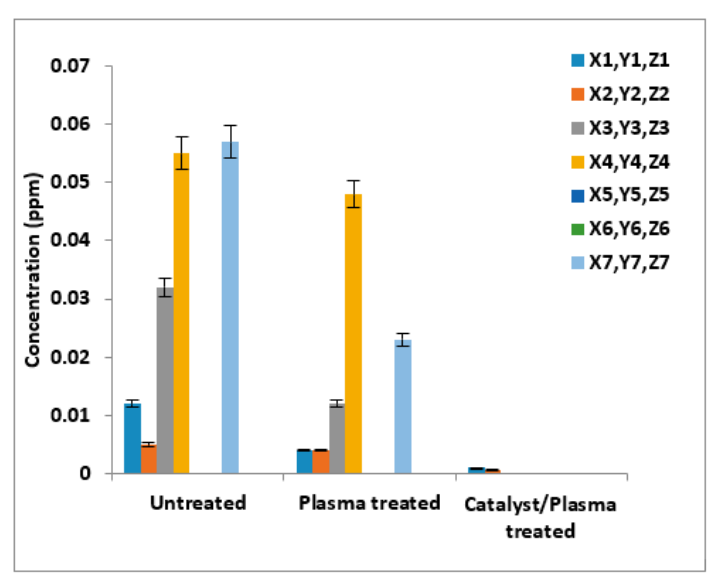
Figure 7. Ni concentration in untreated and plasma-treated water samples.